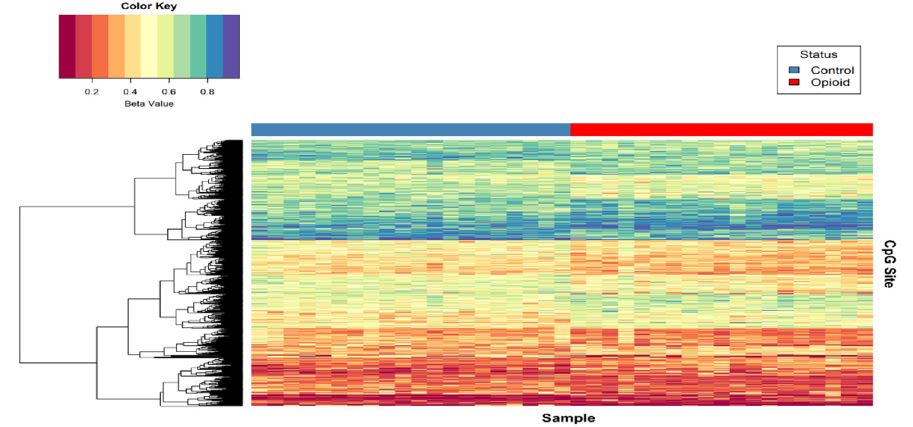
Figure 3. Heat map of normalized beta values for the top differentially methylated CpG sites associated with opioid treatment. Beta values for CpG sites with an unadjusted p < 0.005 and | ∆ β | ≥ 0.05 are shown ( n = 684). Each row contains the beta value for a CpG site, color-coded from 0-1 (see color key, top left), and columns pertain to individual samples ( n = 39). Samples were grouped by opioid-exposure status (top blue bar, left = controls; top red bar, right = opioid-exposed). Hierarchical sorting was performed by CpG site (row), and the dendrogram (left) indicates similarities in methylation trends across all CpG sites.